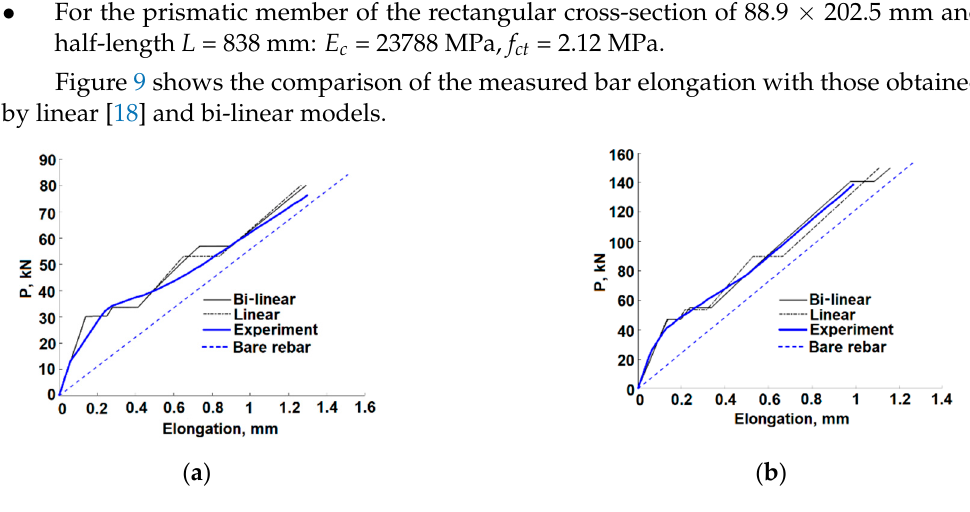
Figure 9. Comparison of bar elongation [11]. ( a ) axisymmetric bar; ( b ) prismatic bar.